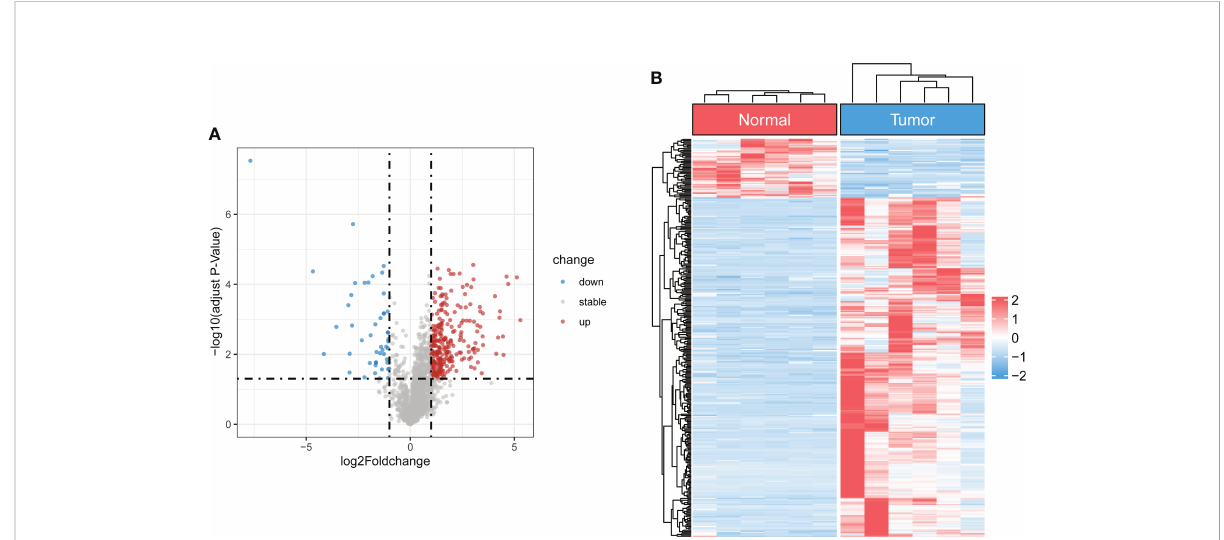
FIGURE 1 Identi fi cation of differentially expressed CRLs in OS (A) The volcano plot of differentially expressed lncRNAs. Blue represent down-regulated CRLs, and red represents upregulated CRLs. (B) Hierarchically clustered heat maps of differentially expressed lncRNAs. Red and blue represent normal and tumor tissues,